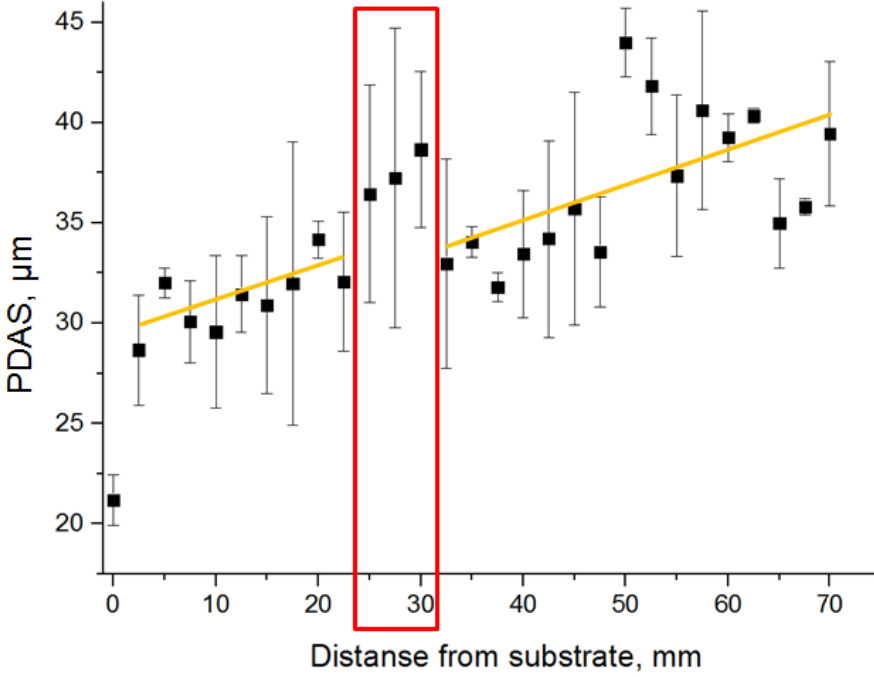
Figure 7. Dependence of the primary dendrite arms spacing on the height of the product. The closed red line highlights the transition region. The orange lines show the linear approximation.